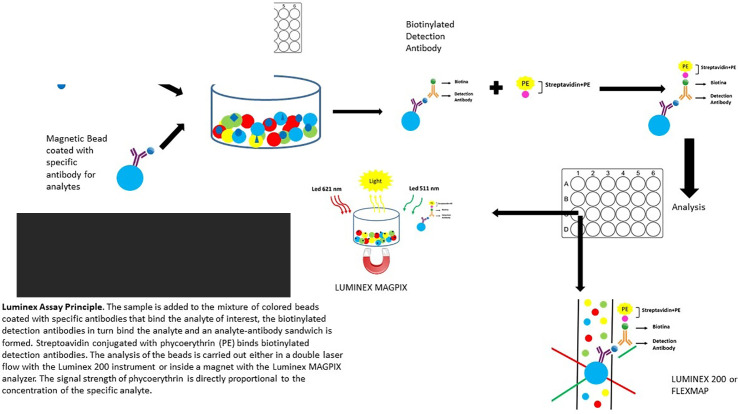
Luminex Assay Principle. The sample is added to the mixture of colored beads coated with specific antibodies that bind the analyte of interest, the biotinylated detection antibodies in turn bind the analyte, and an analyte-antibody sandwich is formed. Streptoavidin conjugated with phycoerythrin (PE) binds biotinylated detection antibodies. The analysis of the beads is carried out either in a double laser flow with the Luminex 200 instrument or inside a magnet with the Luminex MAGPIX analyzer. The signal strength of phycoerythrin is directly proportional to the concentration of the specific analyte.